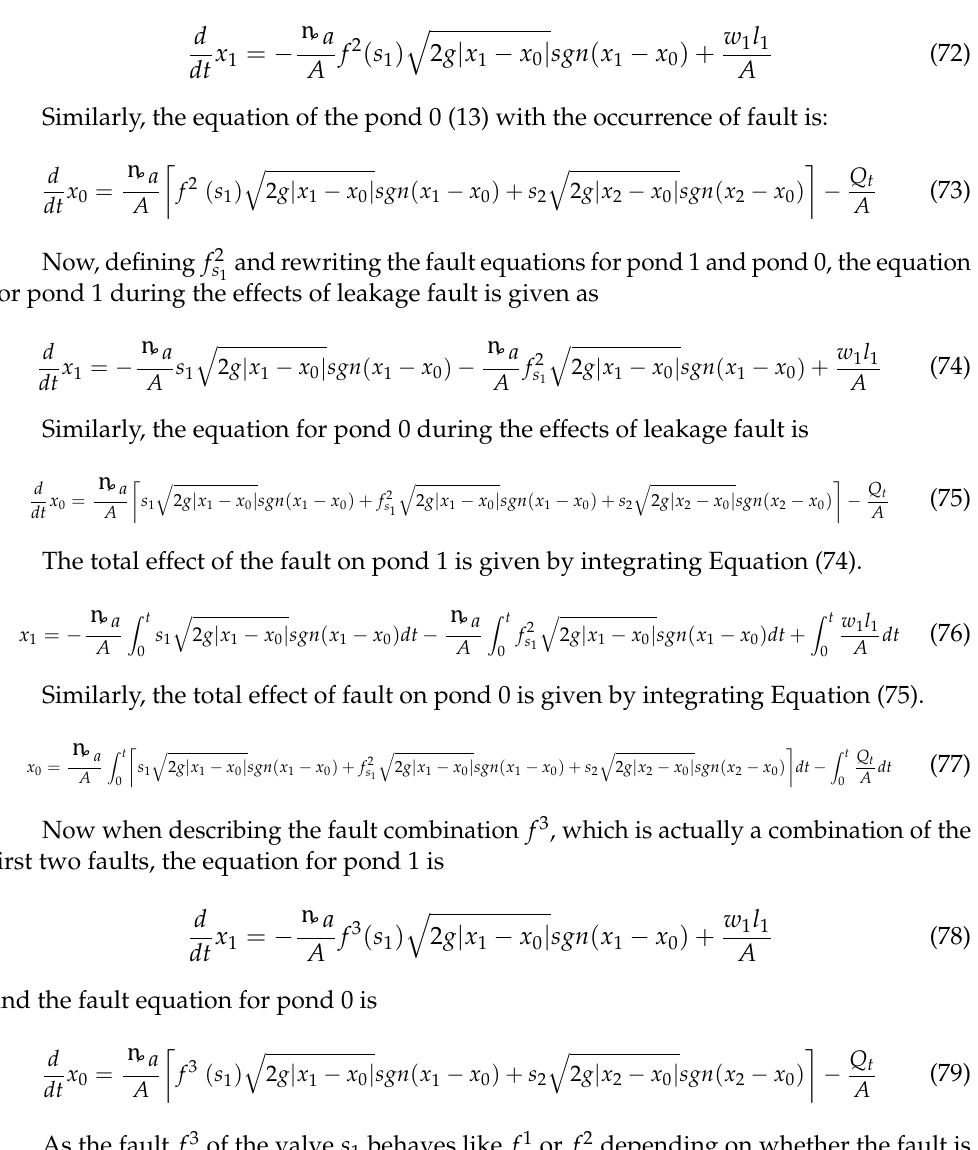
Figure 1. Three-pond hydraulic system.